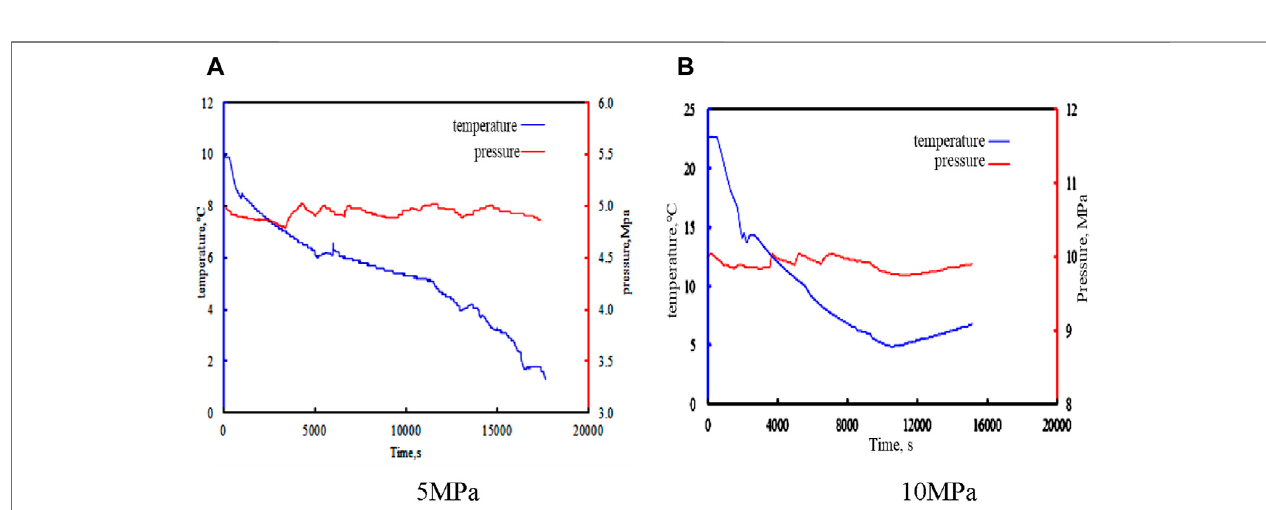
FIGURE 8 | Variation of temperature and pressure at 5% inhibitor concentration. ( A :5 MPa; B :10 MPa).